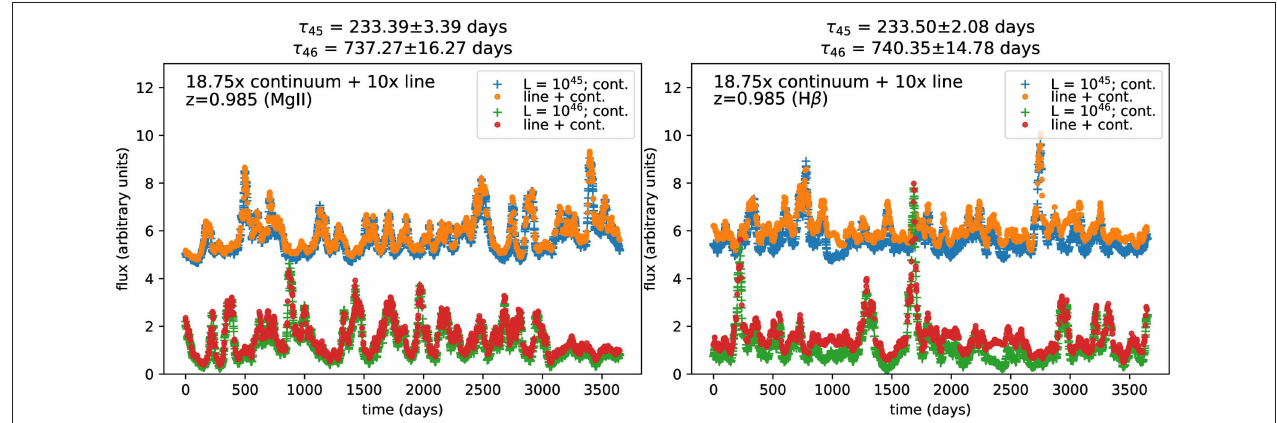
FIGURE 10 | Simulated lightcurves for Mg II and H β at z = 0.985. The lightcurves are generated using Timmer-Koenig method (Timmer and Koenig, 1995) and combining with photometric data from LSST (Ivezi´c et al., 2019). Two cases of luminosity (10 45 and 10 46 erg s − 1 ) are shown, each for the continuum and the line. The continuum and the line contributions are made denser by a factor of 18.75 and 10, respectively. The lightcurves with luminosity 10 45 erg s − 1 is shifted by factor of 4.5 with respect to the lightcurves with luminosity 10 46 erg s − 1 to highlight the differences between the two cases. The corresponding time delays are reported on top of each plot for these two cases of luminosity. The simulations are currently performed using two